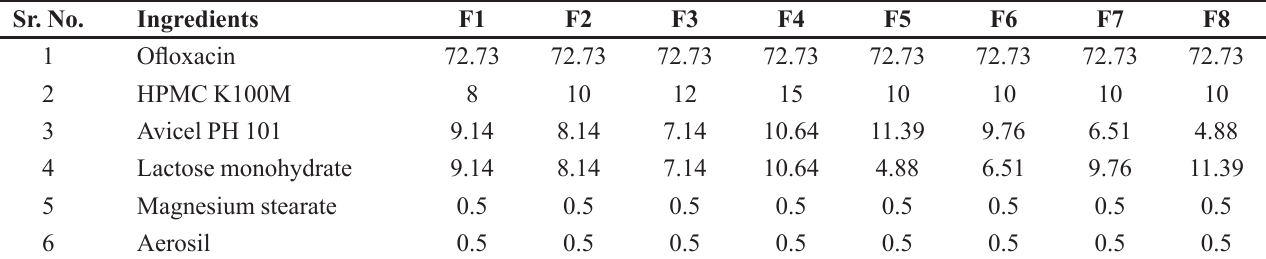
TABLE III - Composition (%w/w) of ofloxacin sustained release tablets (550 mg) Sr.